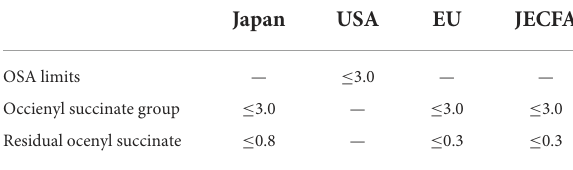
TABLE 1 Regulatory limits of sodium octenyl succinate starch